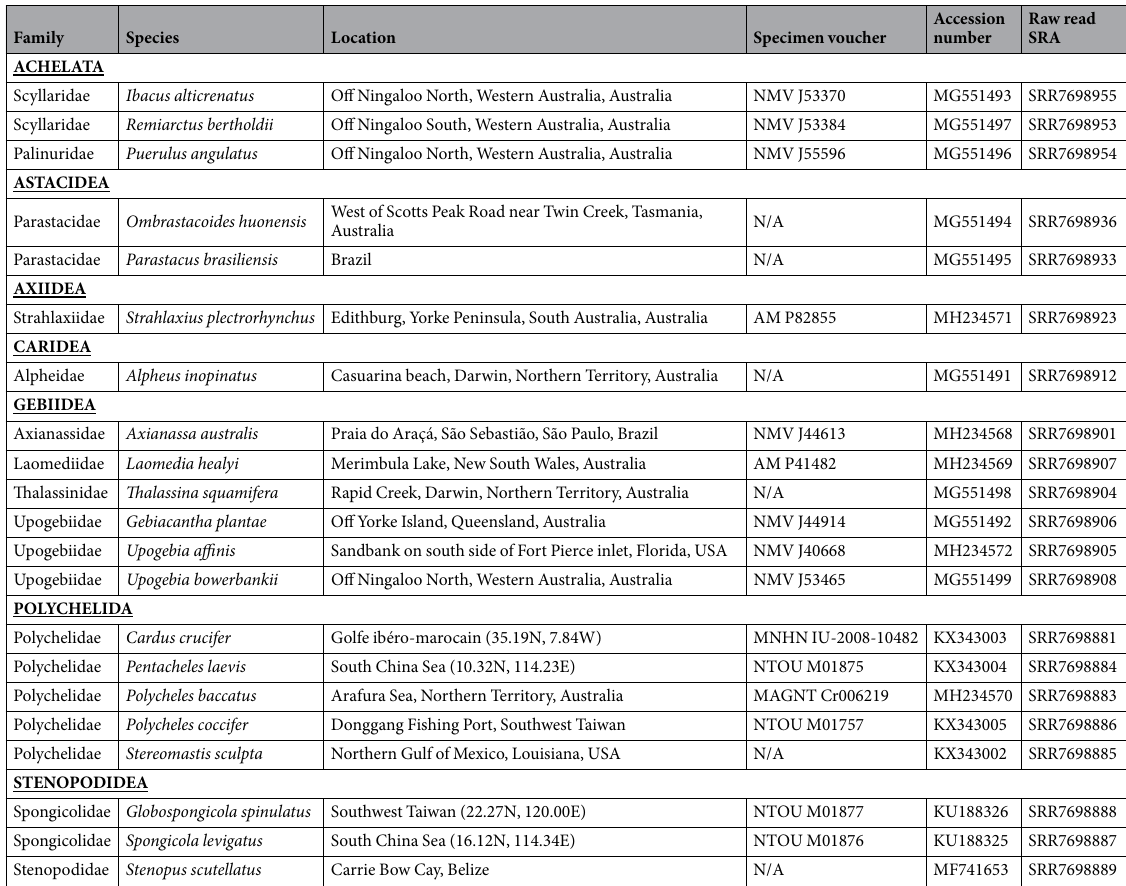
Table 1. Specimen sources and mitogenome accession numbers for 21 decapod species (from 7 infraorders) contributed in this